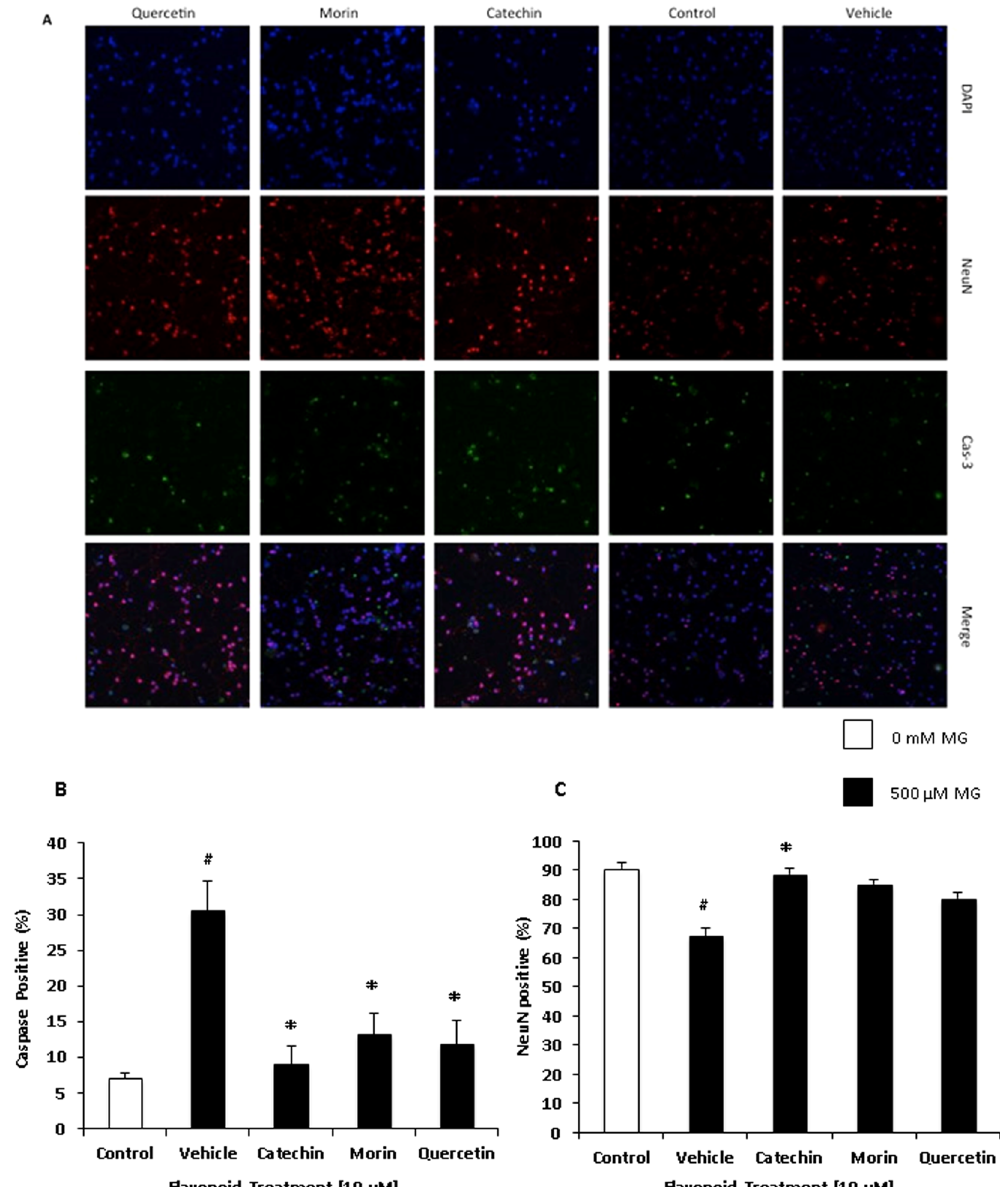
Figure 3. Effects of flavonoid treatment on cell viability and apoptosis. Cerebellar neurons were treated with flavonoid (10 µ M) and MG (500 μ M). Data was determined via immunocytochemistry ( A ). Viability was assessed through detection of cleaved caspase-3 (Cas-3) ( B ) and neuronal specific nuclear protein (NeuN) ( C ). Control = no MG, Vehicle = only MG. Values are means + / − SEM of samples performed in triplicate from several independent experiments, n = 3–4. # P < 0.05 (vs Control), * P < 0.05 (vs Vehicle). Images were quantified with ImageJ, and resulting data were analyzed using an ANOVA. Morin treatment significantly decreased the presence of apoptosis, and catechin and morin significantly increased cell